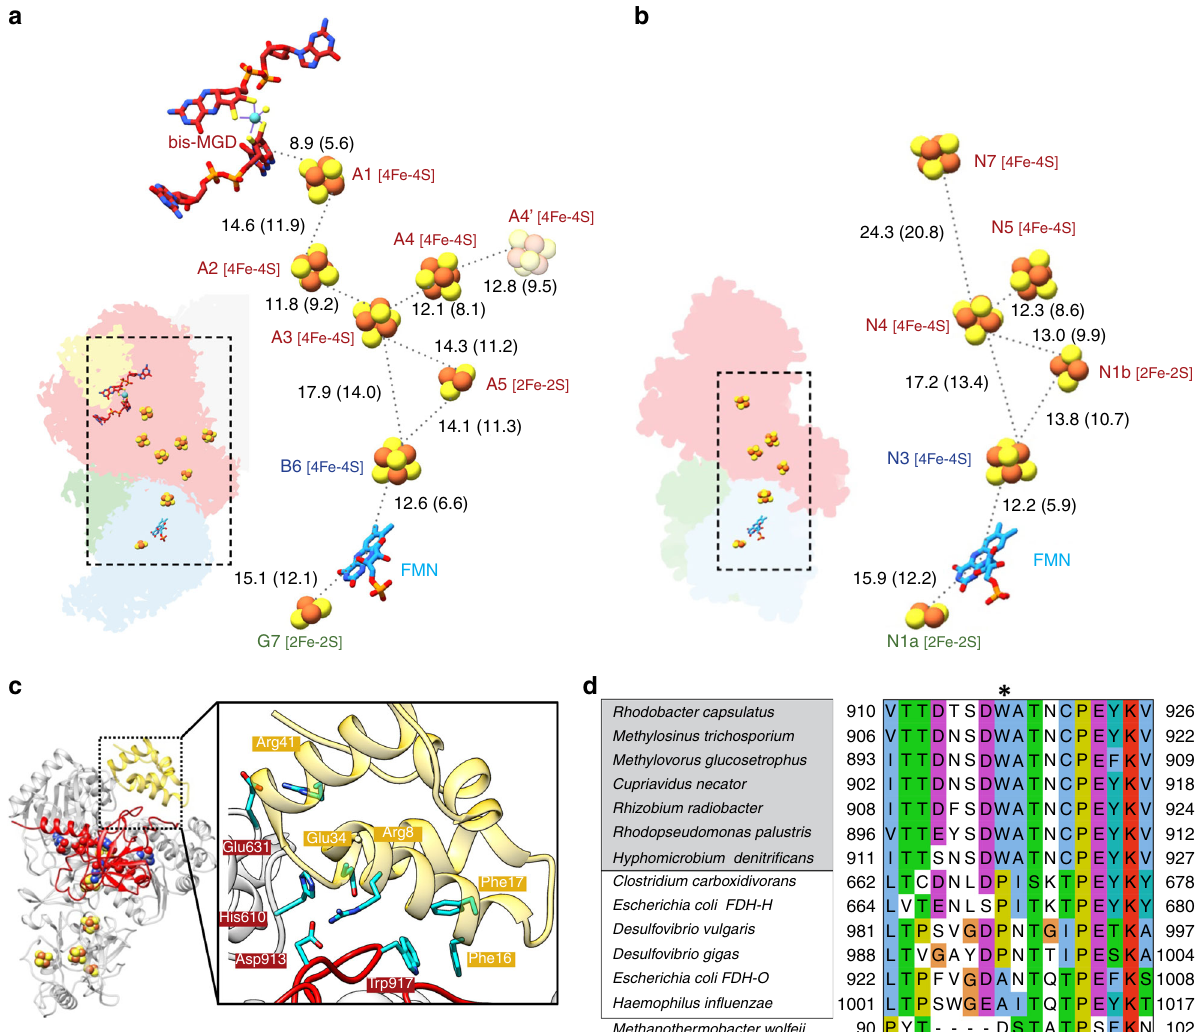
Fig. 2 The electron transfer pathway in Rc FDH. a Overall layout and location of cofactors in Rc FDH. The distances between redox centres are given in angstroms, for both centre-to-centre and edge-to-edge (shown in parentheses) measurements. Fe-S clusters are named according to their position in the electron transfer chain and the Rc FDH subunit they are located in. The inset depicts the location of the cofactor in the atomic model of Rc FDH. b Layout and location of cofactors in subunits Nqo1-3 of the hydrophilic domain of Tt RC I (PDB-ID: 3iam [https://doi.org/10.2210/pdb3IAM/pdb]) depicted in the same orientation as Rc FDH in (a). Colour code is as follows I: Nqo1, red; Nqo2, blue; Nqo3, green. c The FdsA C-terminus (red) forms a cap domain interacting with proximal and distal MGD as well as FdsD (yellow). Cofactors are shown as spheres. Important interacting amino acids in FdsA and FdsD are indicated and shown in stick representation. d Multiple sequence alignment of extended loop in FdsA homologues from organisms with predicted FdsD (grey- shaded) or without predicted FdsD (white-shaded). In Methanothermobacter wolfeii the C-terminus of FdsA is replaced by an additional subunit with low homology in the extended loop. The star indicates the position of the conserved Trp residue in NAD + dependent